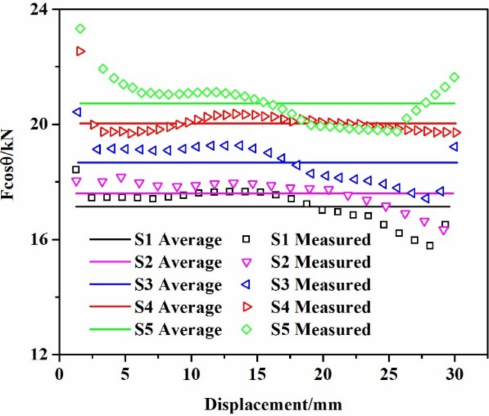
Figure 10. The relationship of parameter F cos θ with the displacement of each specimen in the bending